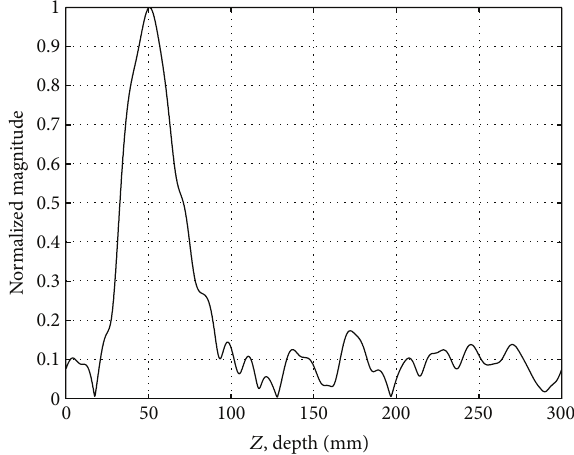
Figure 5: Received signal without calibration.